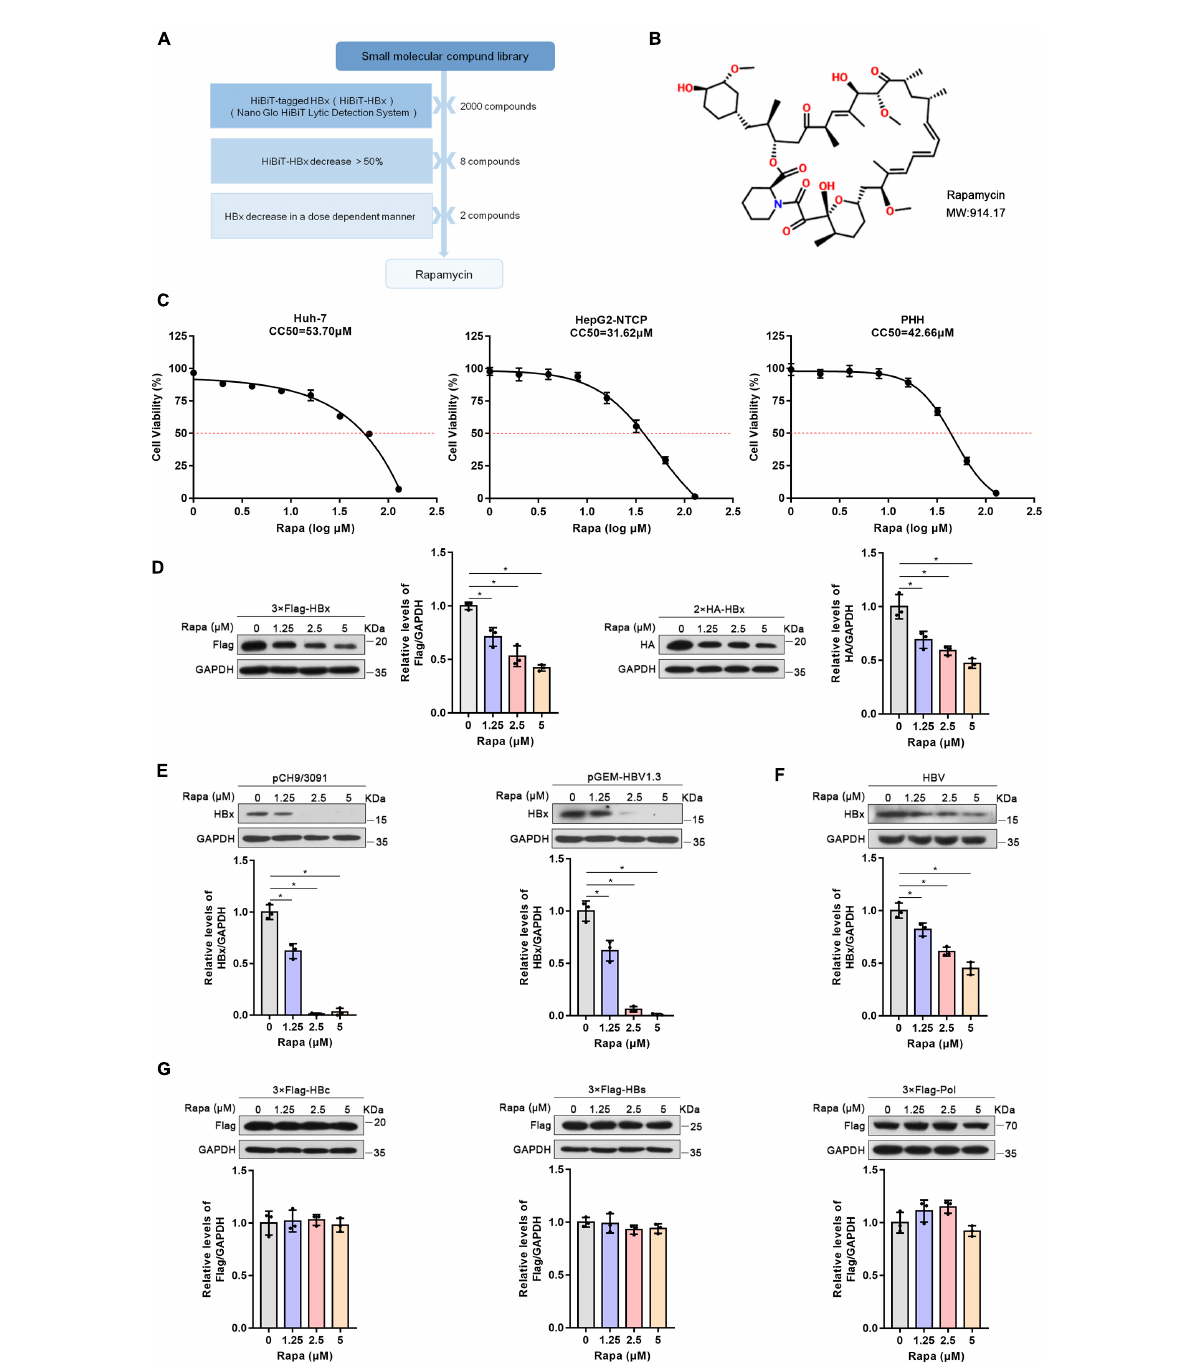
FIGURE1 Rapamycin reduced HBx expression. (A) Schematic process of screening small-molecule compounds targeting HBx. (B) The chemical structure of rapamycin. (C) Effects of rapamycin on the viability of different cells were determined by the MTT assay after treatment with the indicated concentrations of rapamycin for 3 days (Huh-7 cells) or 6 days (HepG2-NTCP and PHH cells). (D,E) Huh-7 cells were transfected with 3 × Flag-HBx, 2 × HA-HBx, pCH9/3091, or pGEM-HBV1.3 plasmid for 24 h and were then treated with rapamycin for 24 h. (F) HepG2-NTCP cells were infected with 10 3 genome equivalents/cells of HBV particles and then treated with rapamycin for 6 days. (G) Huh-7 cells were transfected with 3 × Flag-HBc, 3 × Flag-HBs, or 3 × Flag-Pol plasmids and were then treated with rapamycin for 1 day. The level of the corresponding protein was examined by western blotting analysis, and GAPDH was used as the loading control. Cell lysates were subjected to immunoprecipitation with anti-Flag antibody and then immunoblotted with anti-ubiquitin antibody. The data are presented as the mean ± SD of three independent